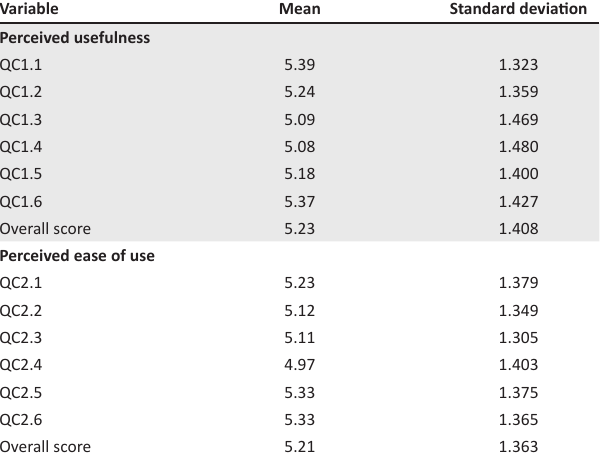
TABLE 2: Descriptive statistics for the beliefs of the technology acceptance model. Variable Mean Standard